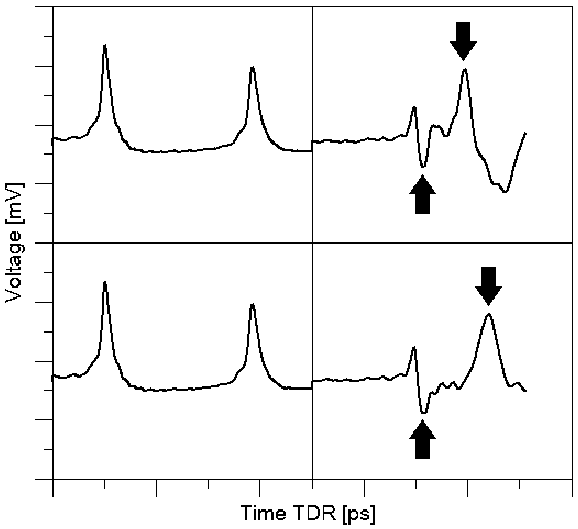
Figure 4. Electric response of the developed sensor for different environments: upper trace—air-dry sample, bottom trace—saturated sample.